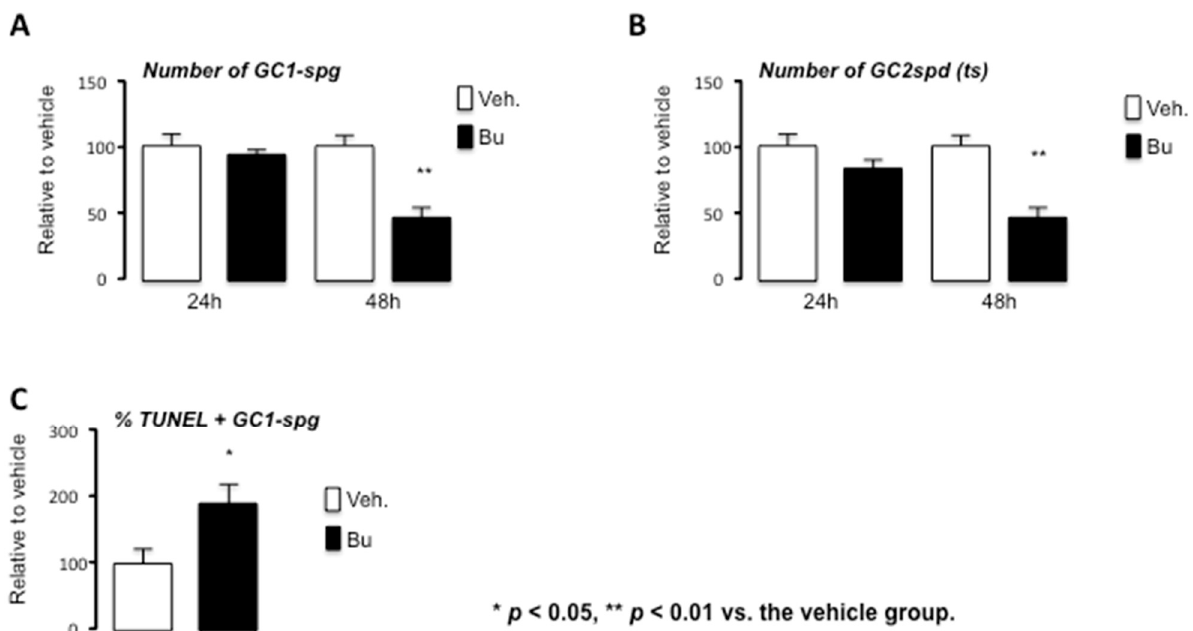
Figure 4. Busulfan treatment leads to the alteration of germ cell numbers through apoptosis in the GC1spg cell line. ( A ) Number of adherent cells after 24 or 48 h of treatment with vehicle or Bu in GC1spg cells. ( B ) Number of adherent cells after 24 or 48 h of treatment with vehicle or Bu in GC2spd (ts) cells. ( C ) The relative number of TUNEL-positive of vehicle- or Bu-treated GC1spg cells after 24 h. For all panels, the data were obtained from at least three independent experiments. The data are expressed as the means ± SEM. Statistical analysis: * p < 0.05, ** p < 0.01 vs. the vehicle group. Veh.: vehicle and Bu: busulfan.